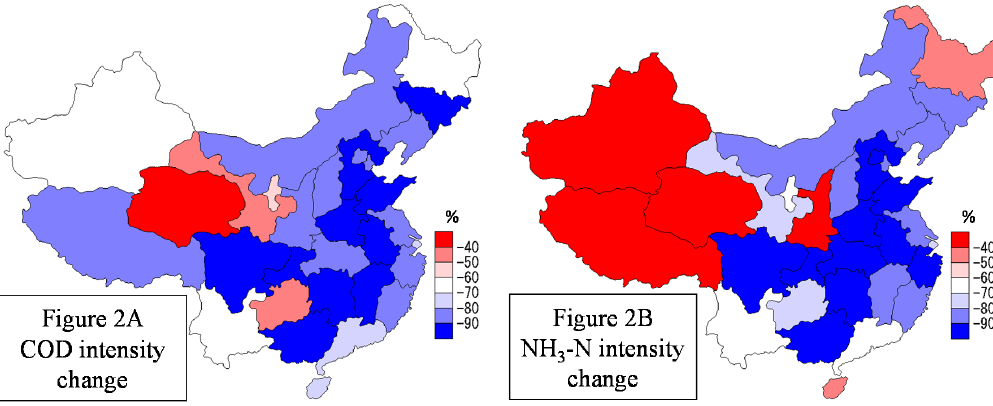
Figure 2. Regional distribution of changes in the intensity of wastewater pollution from 2004 to 2014.